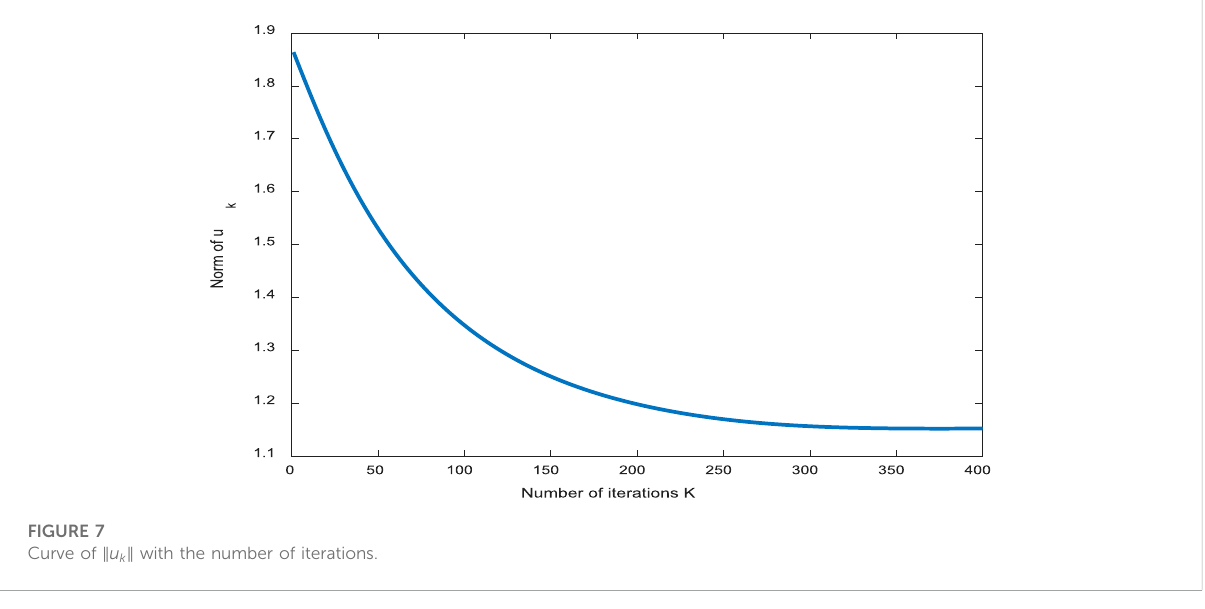
FIGURE 7 Curve of (cid:3) u k (cid:3) with the number of